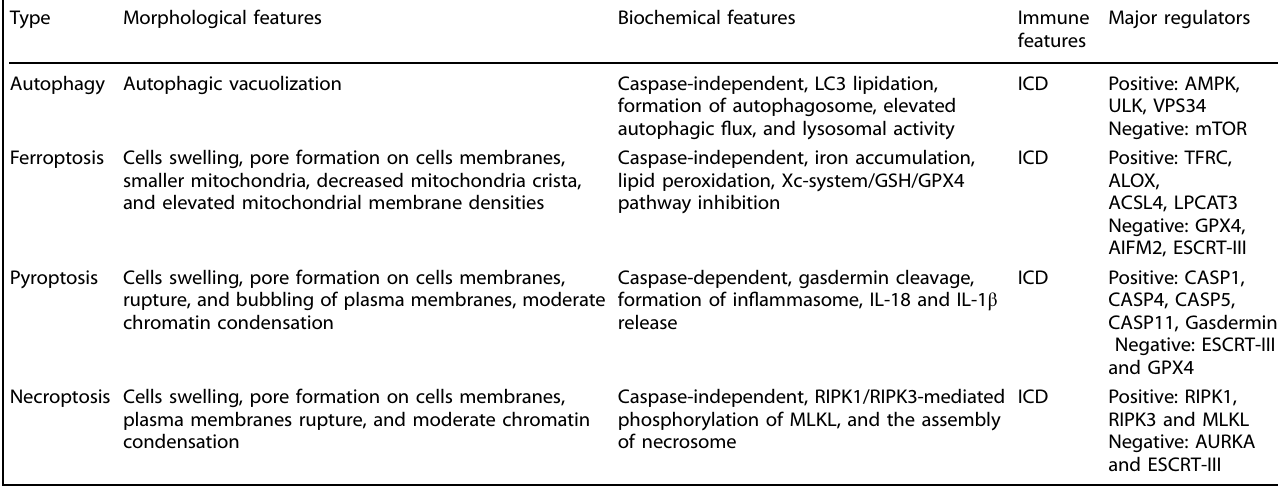
Table 1. Morphological, biochemical, immune features and major regulators of autophagy, pyroptosis, ferroptosis, and necroptosis